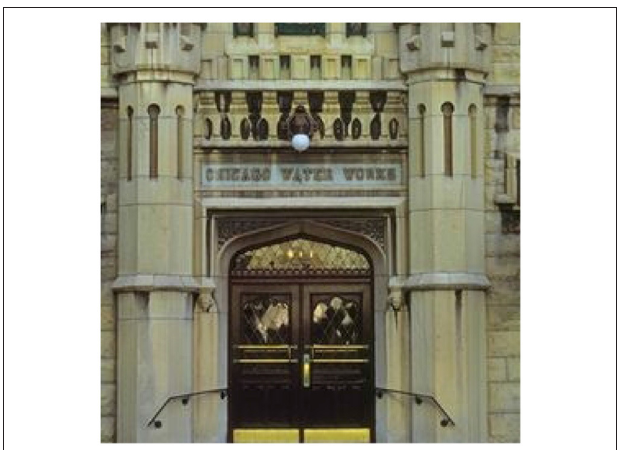
FIGURE 1 | An example of disagreement from LabelMe Ground truth label: insidecity , crowd annotations: [ insidecity :1, tallbuilding :2].